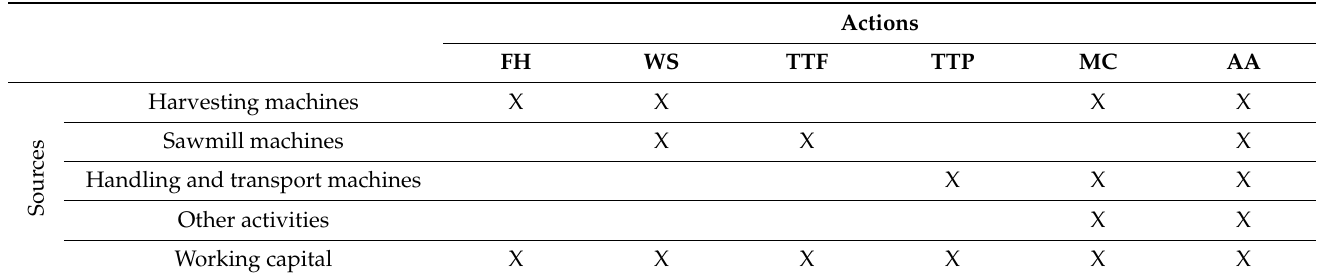
Table 2. Actions and CO 2 sources in the supply chain of chestnut wood to the market of timber products. Legend: FH: Forest harvesting; WS: Wood selection; TTF: Timber transformation; TTP: Timber transport; MC: Monitoring and controls; AA: Administrative